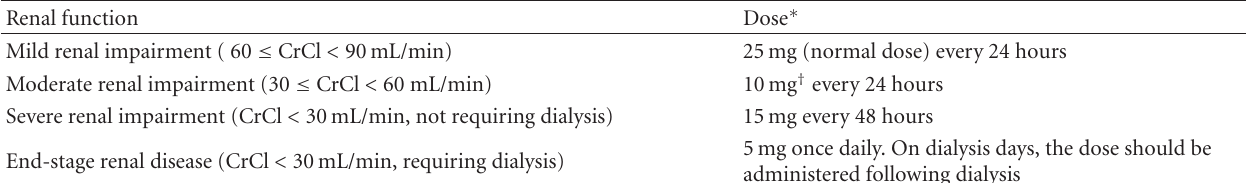
Table 1: Dose adjustments at the start of therapy according to renal function [14]. Renal function Dose ∗